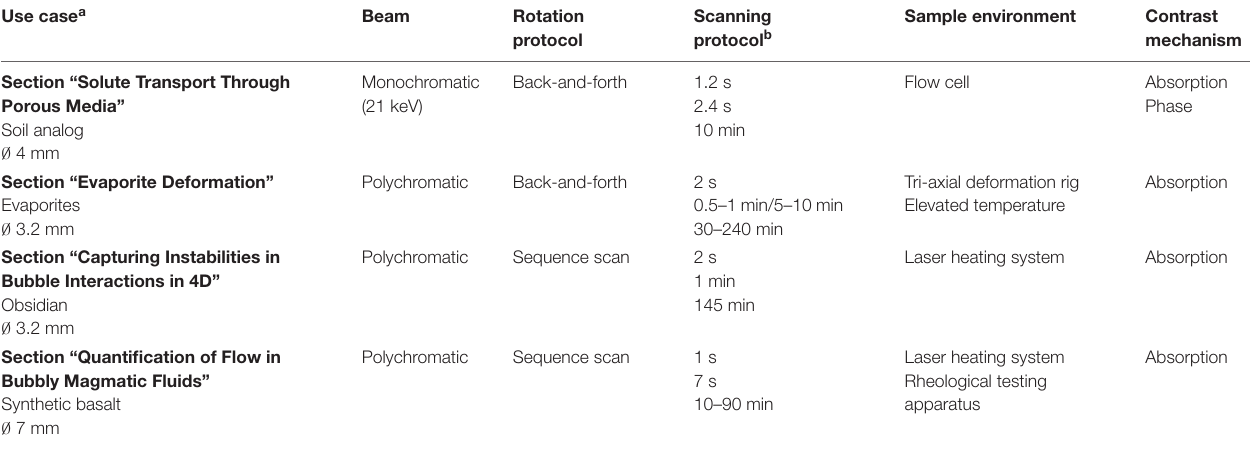
TABLE 2 | Summary of the technical details key to each presented Earth Sciences